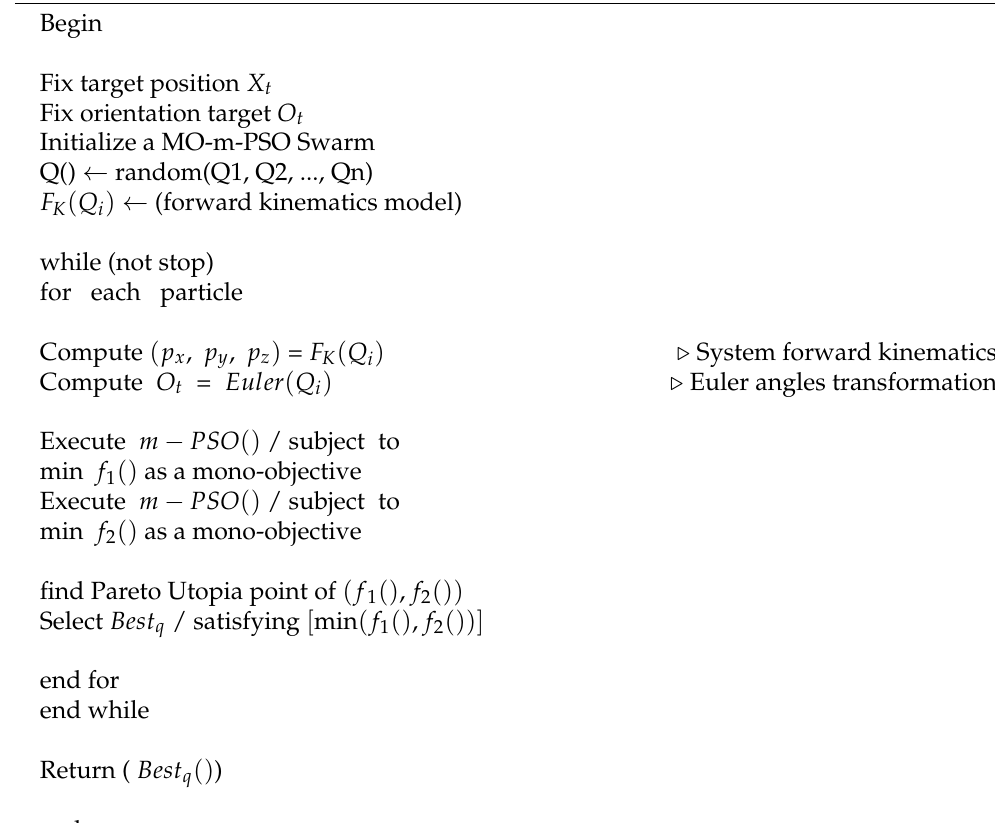
Algorithm 2 Simplified pseudocode of Mo-m-PSO for inverse